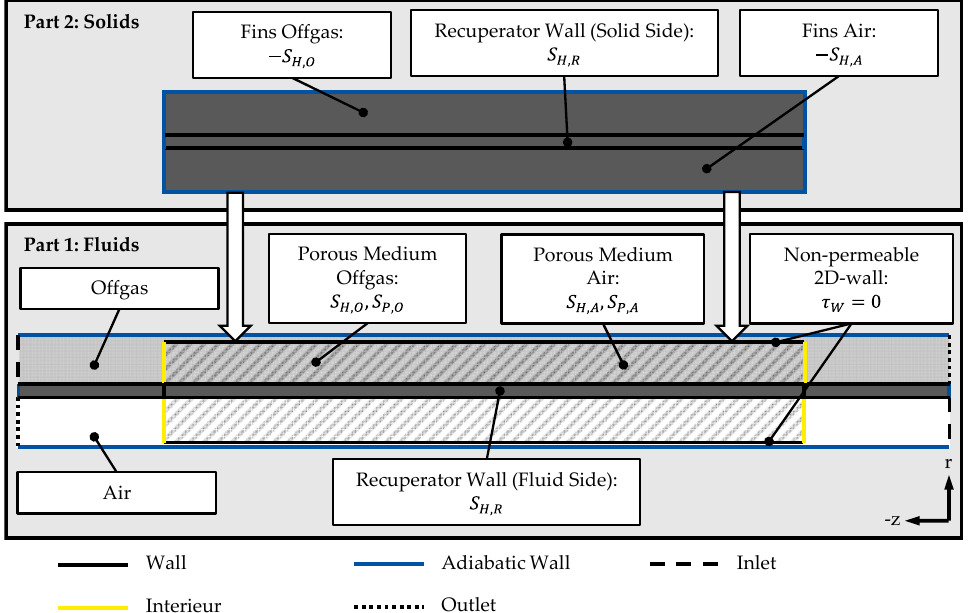
Figure 13. Schematic cross-section of the simplified simulation model.